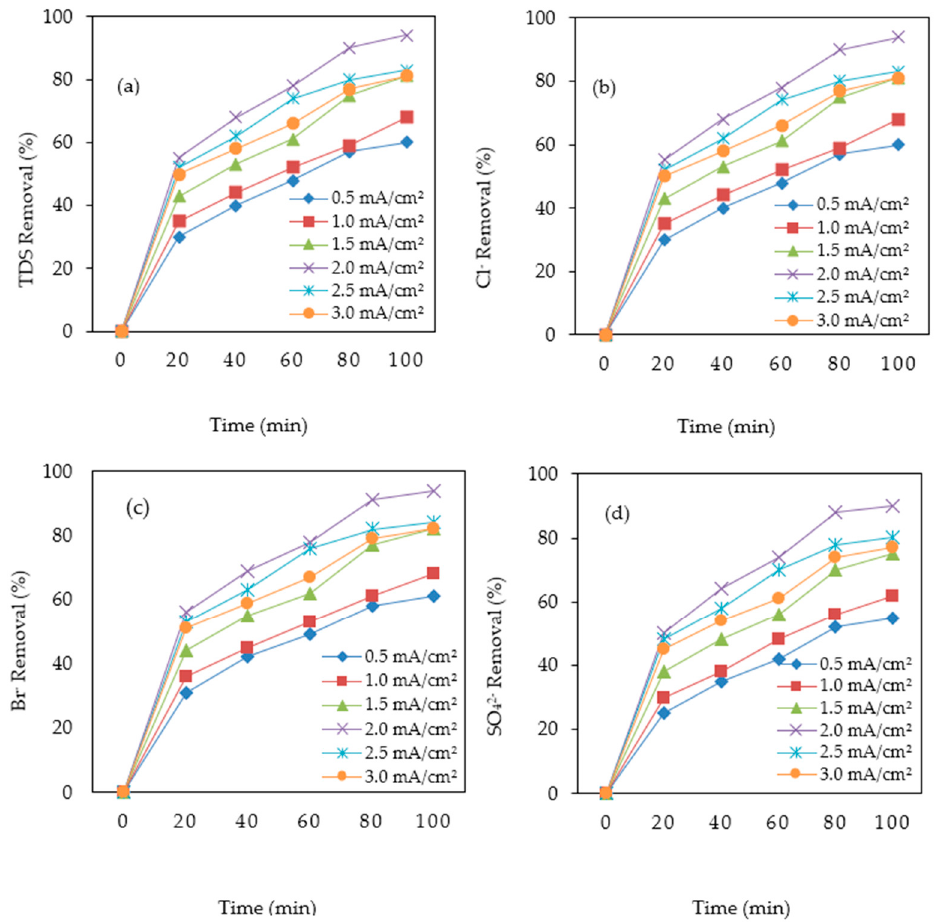
Figure 3. Effect of applied current and reaction time on removal of salts. ( a ) TDS; ( b ) Cl − ; ( c ) Br − ; and ( d ) SO 42 − .